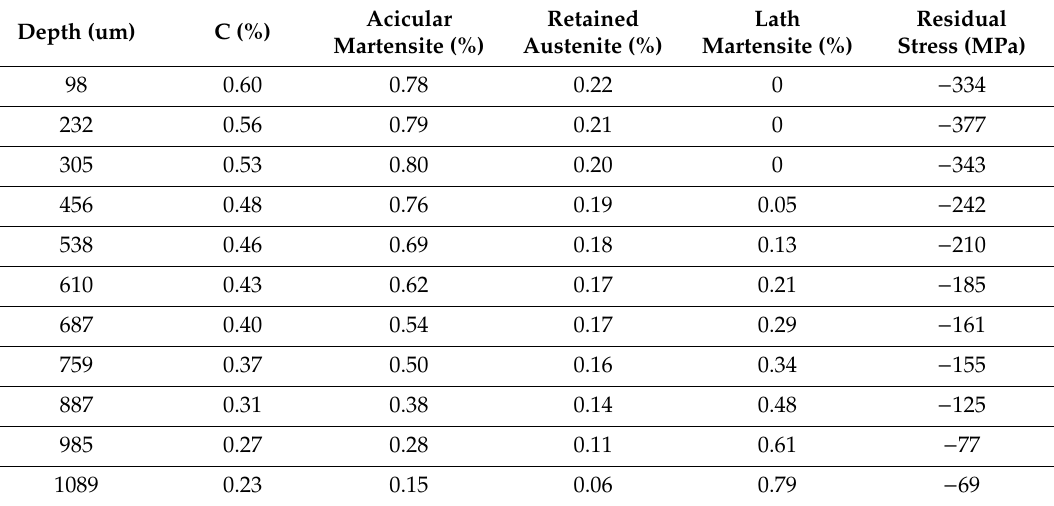
Table 4. 23CrNi3Mo carburized steel Process 1